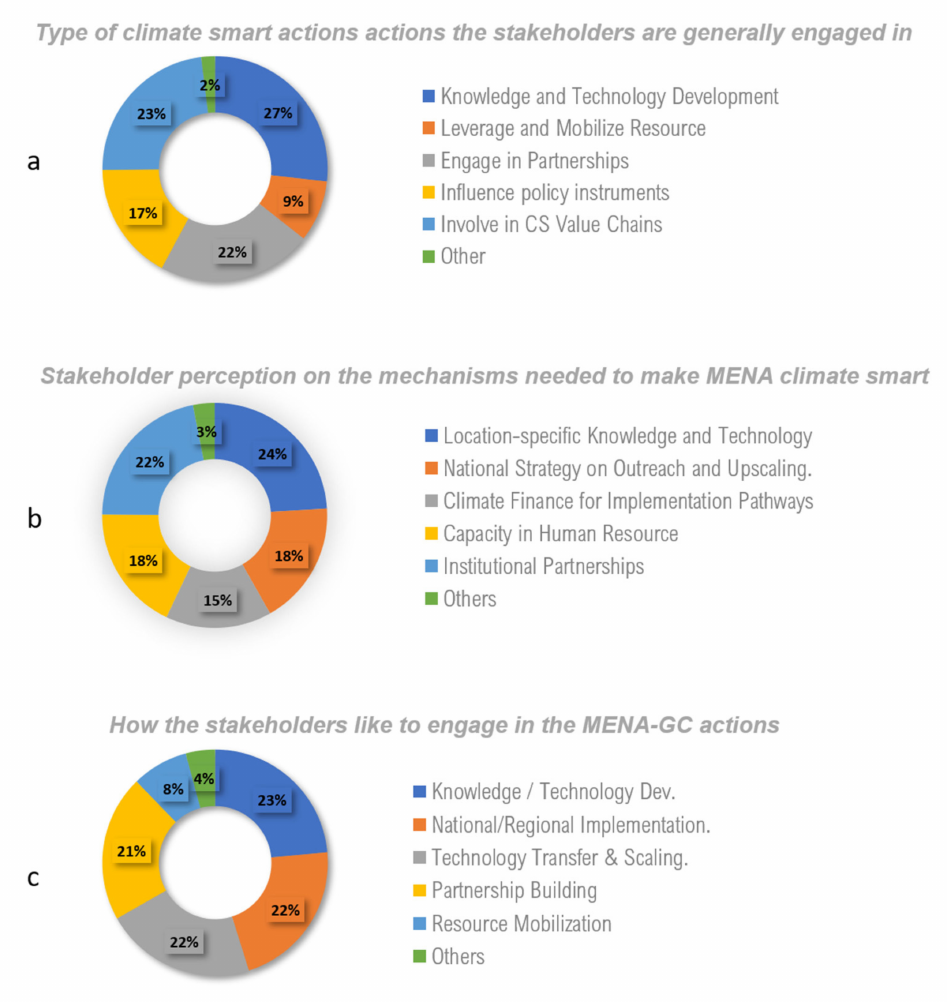
Figure 5. The pie chart represents the engagement of the stakeholders in different consultation tiers: ( a ) climate-smart actions, ( b ) perceptions about mechanisms required for making MENA climate smart, ( c ) stakeholders’ likeliness to engage in MENA GC